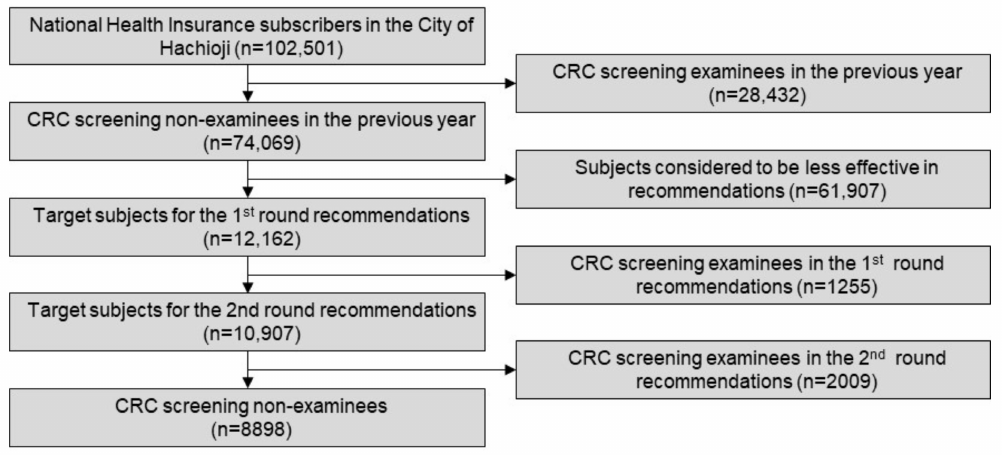
Figure 3. A consort diagram of the